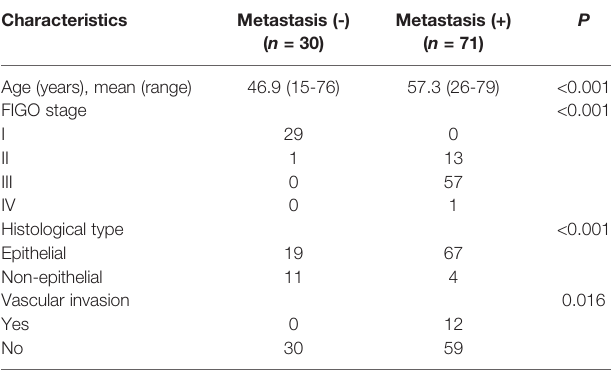
TABLE 1 | Characteristics of patients.